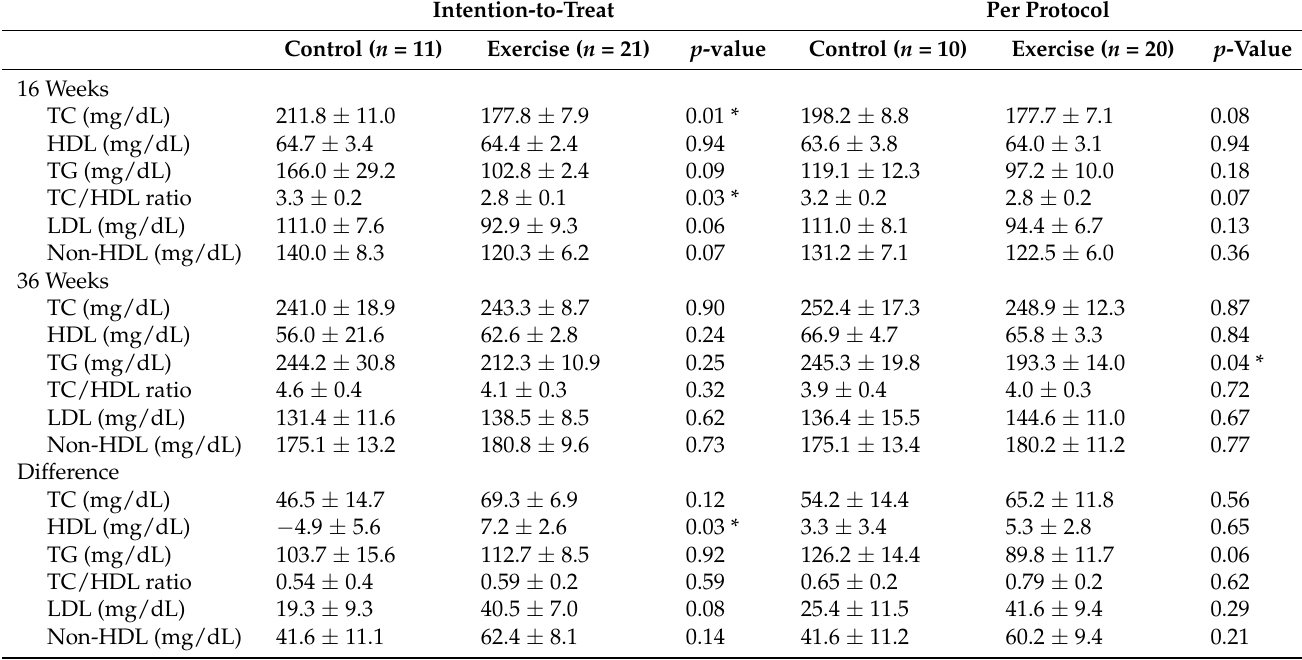
Table 3. Maternal lipid profiles between aerobic exercise and non-exercising